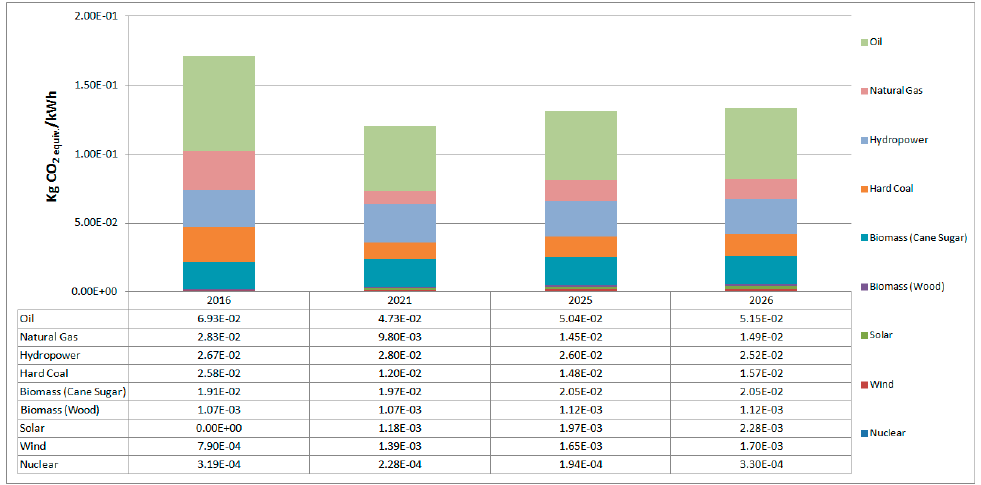
Figure 6. This figure indicates the relative impact of the electricity generation in Brazil (2016–2026) in terms of